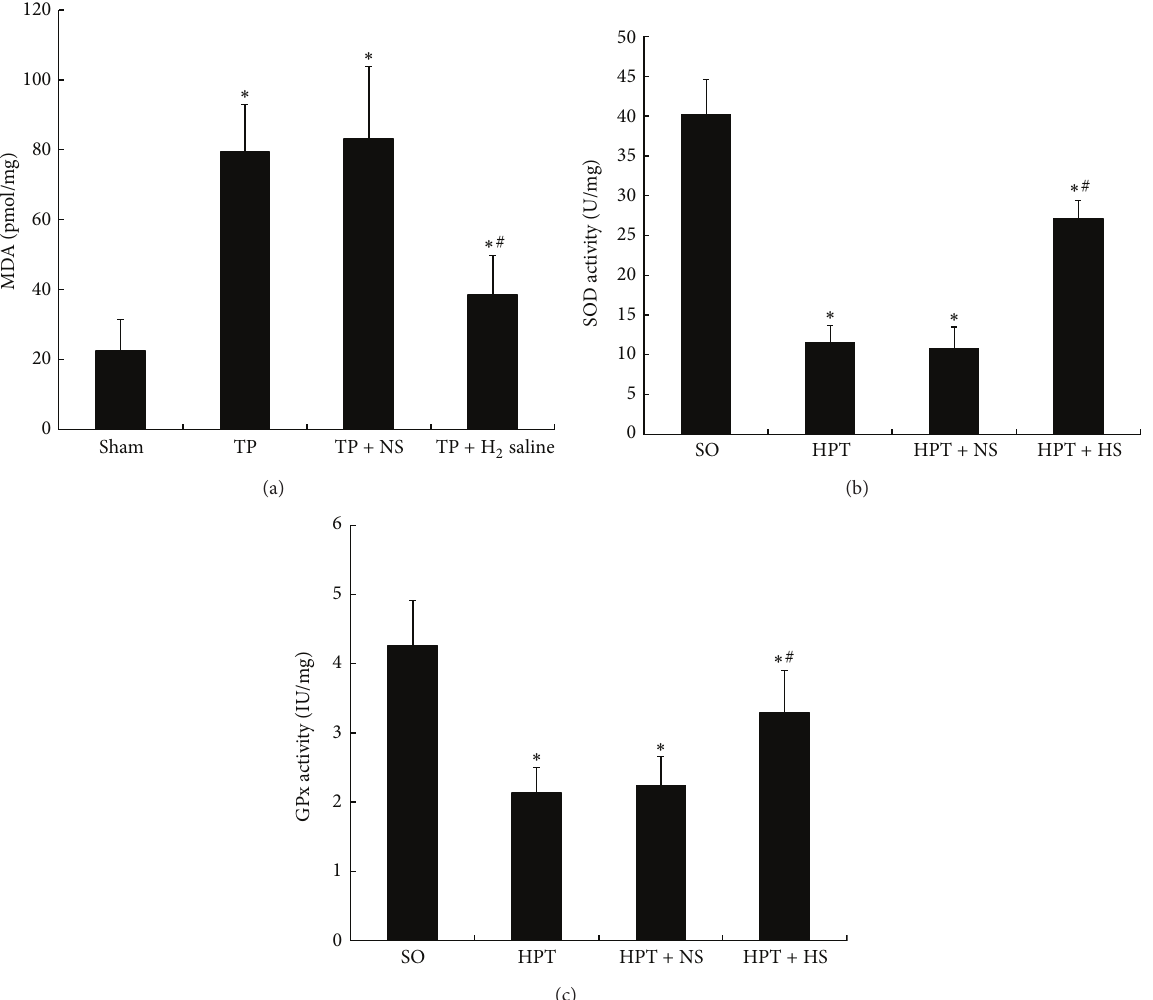
Figure 4: Pancreatic tissue levels of MDA, SOD, and GPx in rats exposed to various treatments. After I/R injury, the MDA level (a) in pancreatic tissue presented a pronounced increase, and the SOD (b) and GPx (c) in the pancreas were nearly depleted. The administration of hydrogen-rich saline (0.6 mM, 6 mL/kg) effectively improved the SOD and GPx levels in the pancreas with significantly reduced pancreatic MDA levels. ∗ 𝑃 < 0.05 compared with the SO group; # 𝑃 < 0.05 compared with the HPT + NS